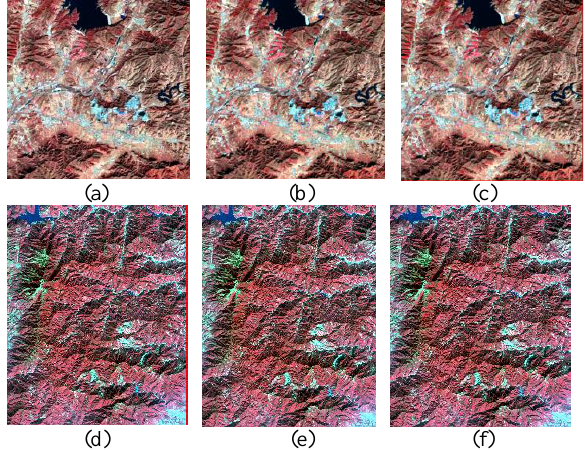
Figure 3. The distribution map of PIFs.(a) is results of CCA(Landsat-8);(b) is results of KCCA(Landsat-8);(c) is results of CCA(GF-1); (d) is results of KCCA(GF-1) Relative radiometric normalization is performed with the regression model. The outcomes suggest that under the condition set in this study, the KCCA-based MAD algorithm can be satisfactorily applied to relative radiation normalization. The results of relative radiometric normalization are as follows Figure 4: